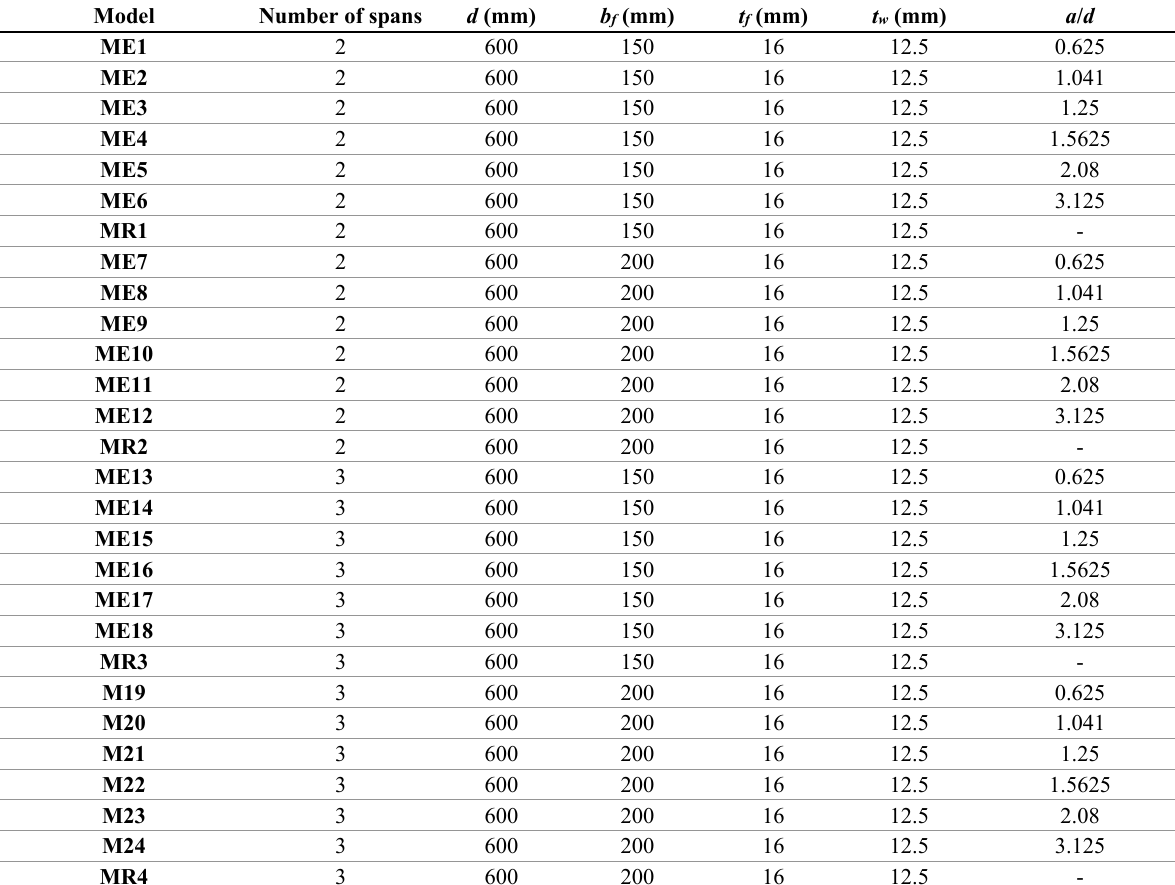
Table 3. Numerical models for analyzing the stiffeners influence.